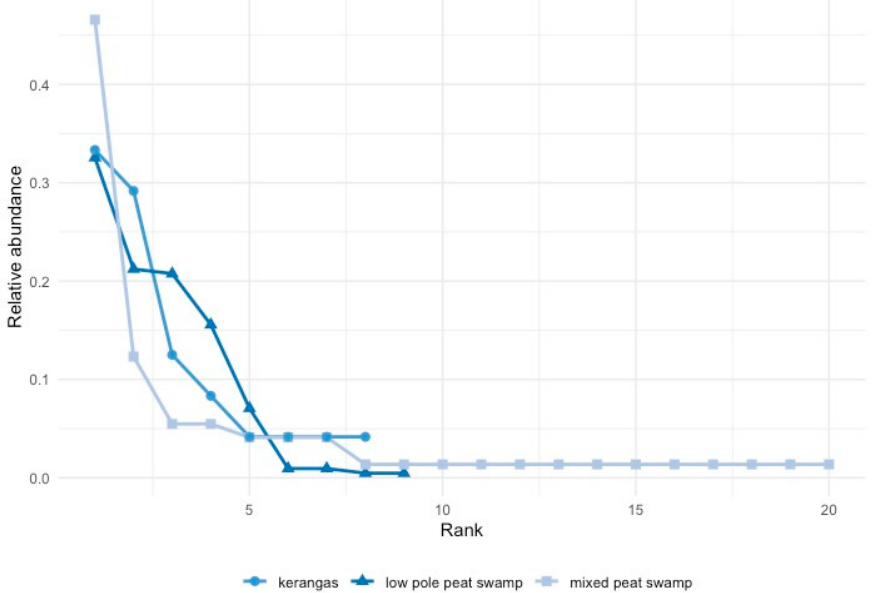
Figure 5. Rank-abundance graph (Anisoptera and Zygoptera) for the three studied habitat types: mixed peat swamp, kerangas, and low pole peat swamp. The steep slopes observed at lower ranks are due to the presence of dominant species, while the long tails observed at lower ranks are due to the presence of singletons (single individuals of a species).